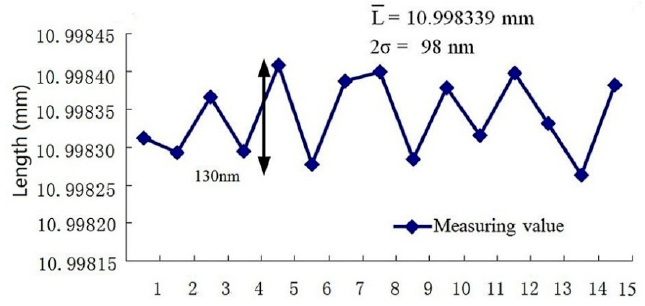
Figure 12. Calibration of the diameter of the probe ball by reference.